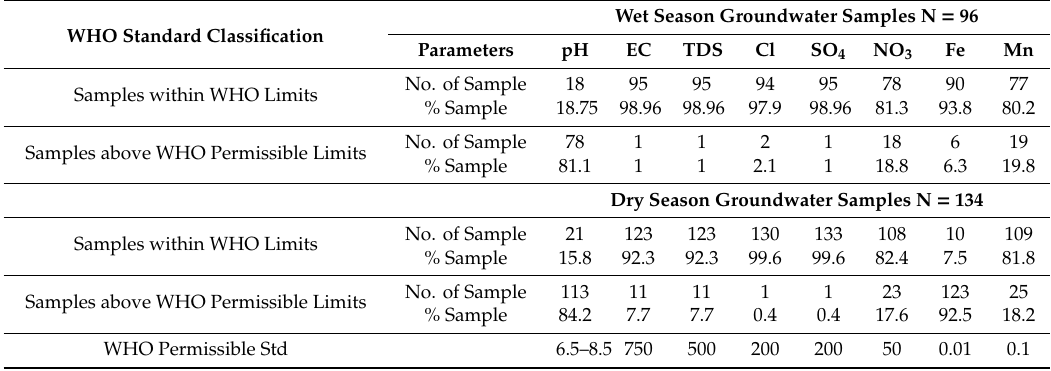
Table 6. Comparing some selected ions from the wet season with the World Health Organization (WHO) water quality highest permissible